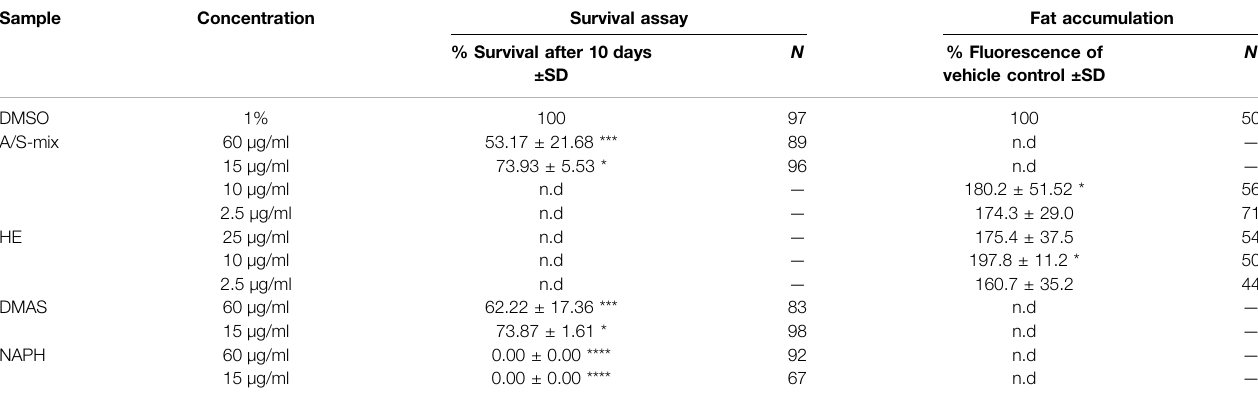
TABLE 2 | Effect of hydroxynaphthoquinones and samples derived from Alkanna tinctoria L. Tausch on C. elegans survival and fat accumulation. Survival rates (%) after 10 daysupontreatment,aswellasfataccumulationassessedasNilered fl uorescence(%ofvehiclecontrol).Vehiclecontrolwas1%DMSOinbothassays. N isthetotal number of worms assayed for the respective assay. Signi fi cance was assessed by one-way ANOVA with Dunnett ’ s post-test. Sample